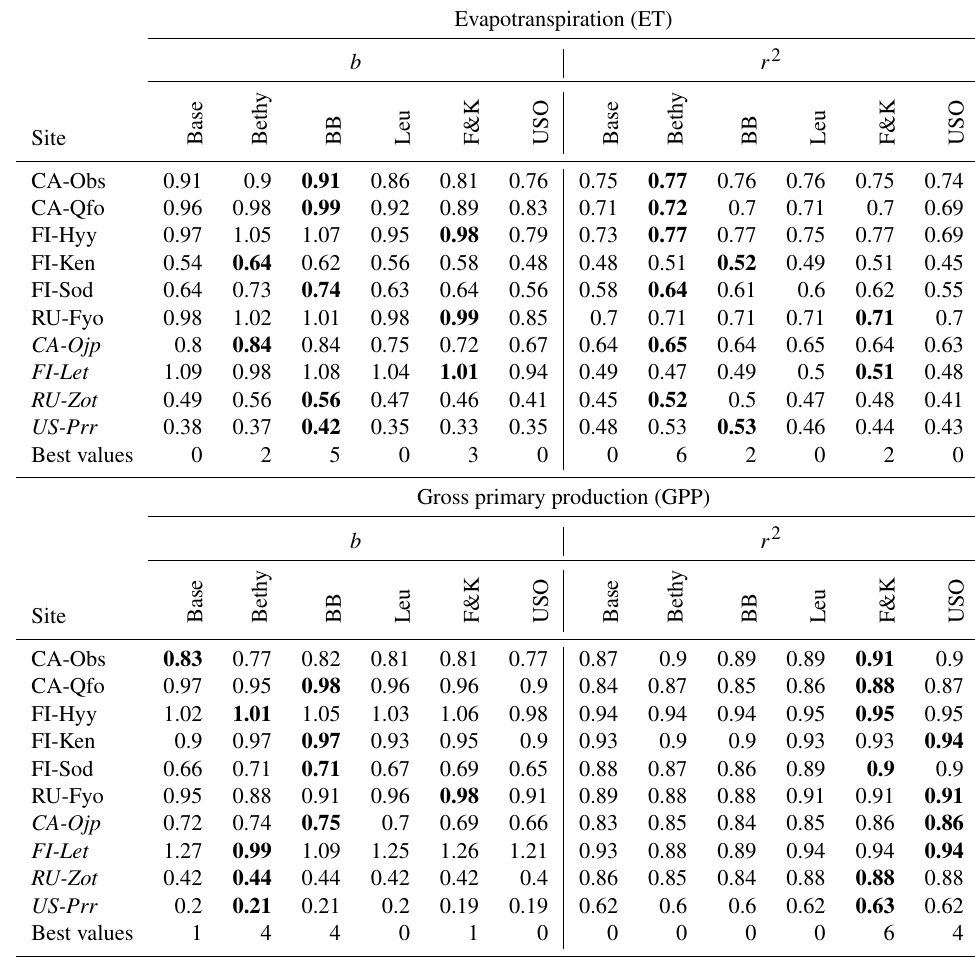
Table 6. Slope of the regression line ( b ) and the coefficient of determination ( r 2 ) for the different stomatal conductance formulations during the validation period with the optimised parameters. We have written the best values of b and r 2 in boldface for each site and italicised the abbreviations of the separate validation